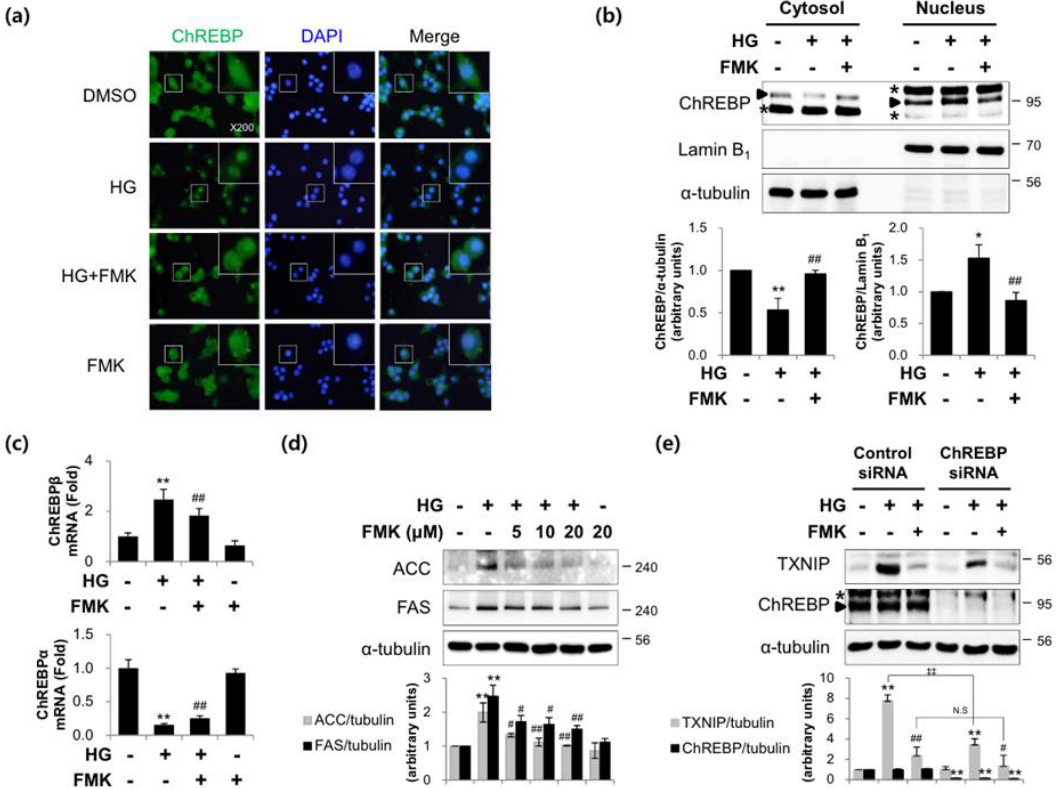
Figure 5. FMK reduced the HG-induced nuclear translocation and activity of ChREBP. ( a ) INS-1 cells were pretreated with FMK (20 µ M) for 1 h, and then incubated with high glucose (HG, 25 mM) for 6 h. Cells were stained with anti-ChREBP antibody, and nuclei were stained with DAPI and examined under a fluorescence microscope (original magnification, × 200). ( b ) INS-1 cells were pretreated with FMK (20 µ M) for 1 h and then incubated with HG for 6 h. Cytosolic and nuclear protein extracts were isolated, and protein levels were measured by immunoblotting. The asterisk indicates a non-specific band. ( c ) INS-1 cells were pretreated with FMK (20 µ M) for 1 h, and then incubated with HG for 24 h. mRNA levels of ChREBP α and ChREBP β were measured by qRT-PCR. Relative expression levels were normalized versus GAPDH. Results are expressed as the means ± SDs of three independent experiments. * p < 0.05 and ** p < 0.01 vs. non-treated controls, # p < 0.05 and ## p < 0.01 vs. HG-treated cells ( d ) INS-1 cells were pretreated with FMK (20 µ M) for 1 h, and then incubated with HG for 24 h. Protein levels were assessed by immunoblotting. ( e ) INS-1 cells were transfected with control or ChREBP siRNA (100 pM). After 48 h, cells were pretreated with FMK (20 µ M), and then incubated with HG for 24 h. Protein levels were measured by immunoblotting. The graph shows the densitometric quantification of western blot bands. Results are expressed as means ± SDs and are representative of three independent experiments. ** p < 0.01 vs. non-treated controls, # p < 0.05 vs. HG-treated cells, ‡‡ p < 0.01; N.S., not significant. The asterisk indicates a non-specific band. 2.5. Glucose 6-phosphate is not a Target of FMK-mediated ChREBP Regulation. To determine whether FMK affects the formation of G6P, intracellular G6P levels were measured. As shown in Figure 6, the G6P levels were unaffected by FMK treatment, suggesting G6P formation is not involved in the inhibition of the HG-induced ChREBP activation by FMK.